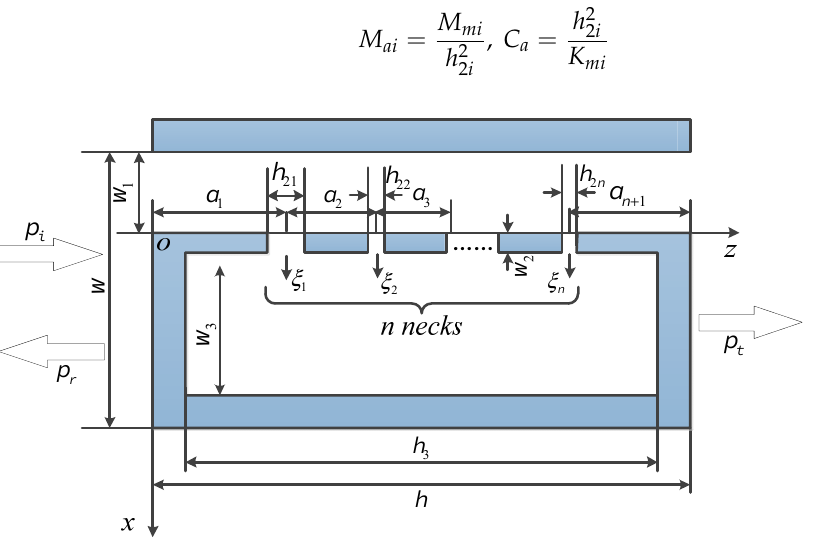
Figure 1. Schematic diagram of a DHR system.